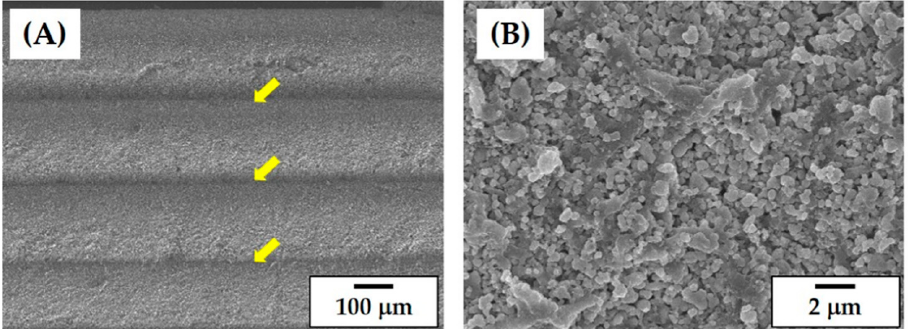
Figure 9. Representative SEM images of the CaP framework showing ( A ) its surface morphology in the building direction and ( B ) its microstructure.